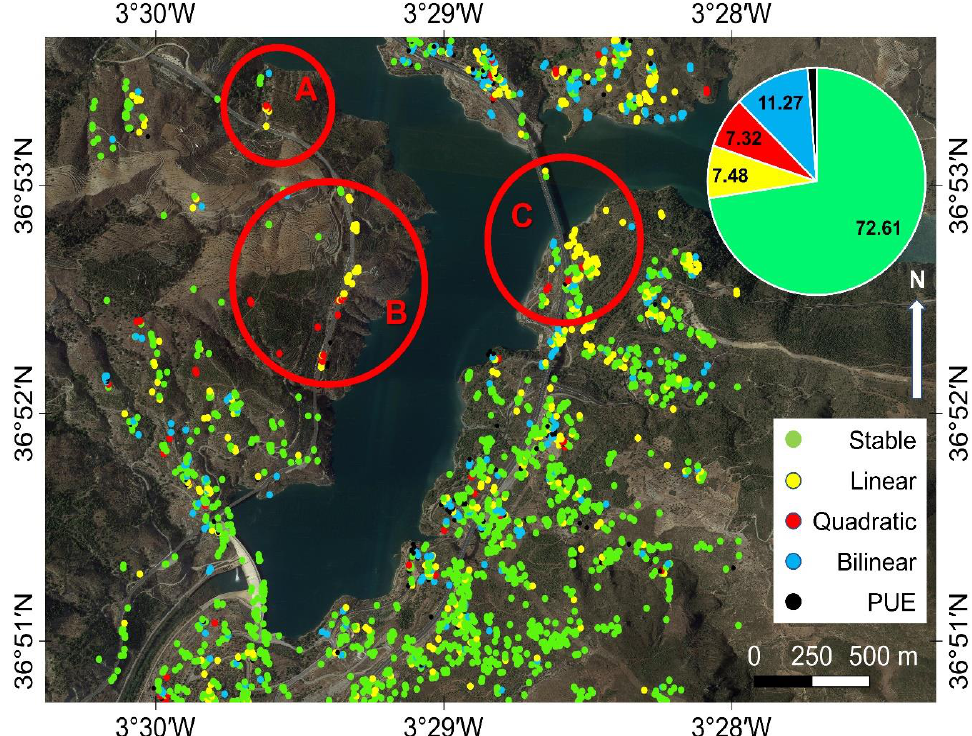
Figure 2 . Ground deformation TS classified map of the Rules Reservoir, including Cortijo de Lorenzo area (A), the El Arrecife Landslide (B), and the Rules Viaduct Landslide (C) in red circles. The pie chart shows the portion of each deformation trend over the study